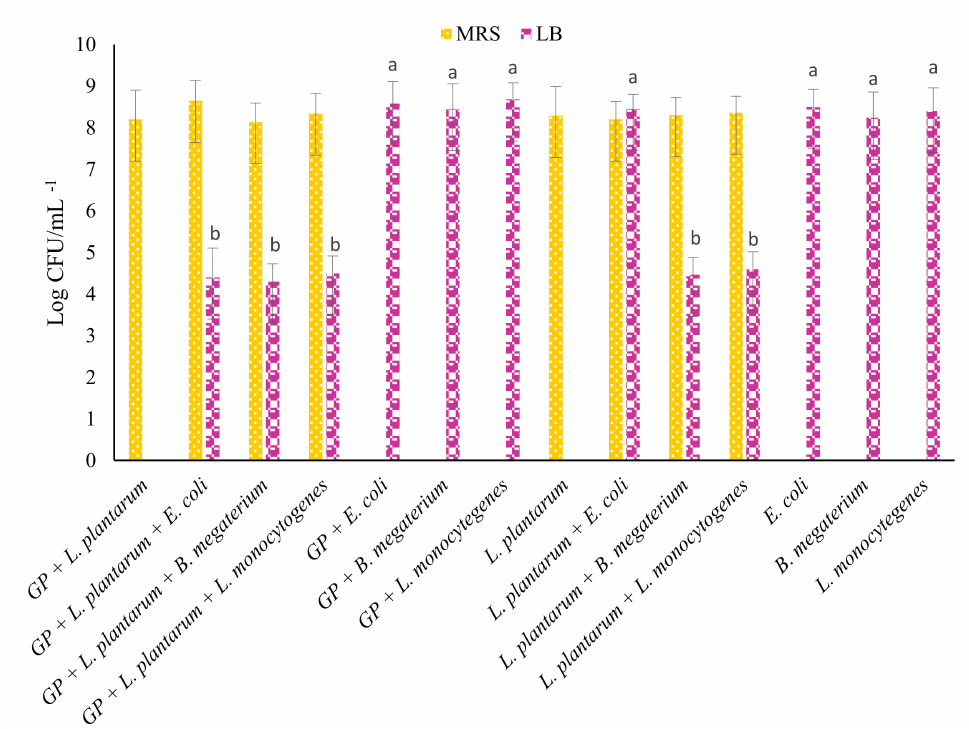
Figure 2. Viable cell count (log CFU mL − 1 ) of probiotics and pathogens after 24 h of growth at 37 ◦ C in MRS and LB. Data are presented as the average of biological triplicates ± SD. Different letters indicate statistically significant differences among LB samples. Different letters ( a–b ) indicate significant differences ( p < 0.05) in LB count according to Tukey’s HSD test. Abbreviations: GP, grape pomace extract; LB, Luria Bertani; MRS, De Man, Rogosa and